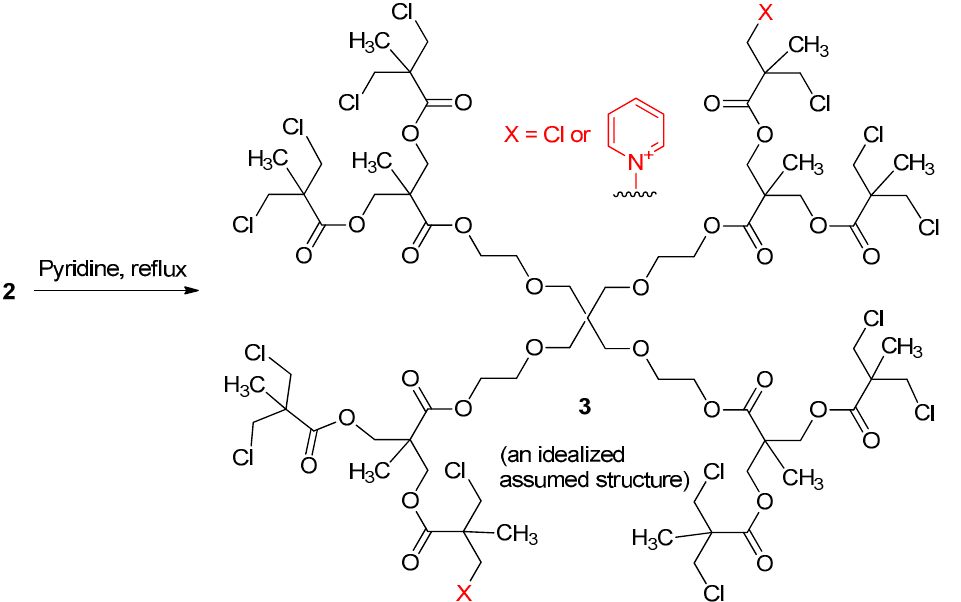
Scheme 3. Reaction of polychloride 2 with